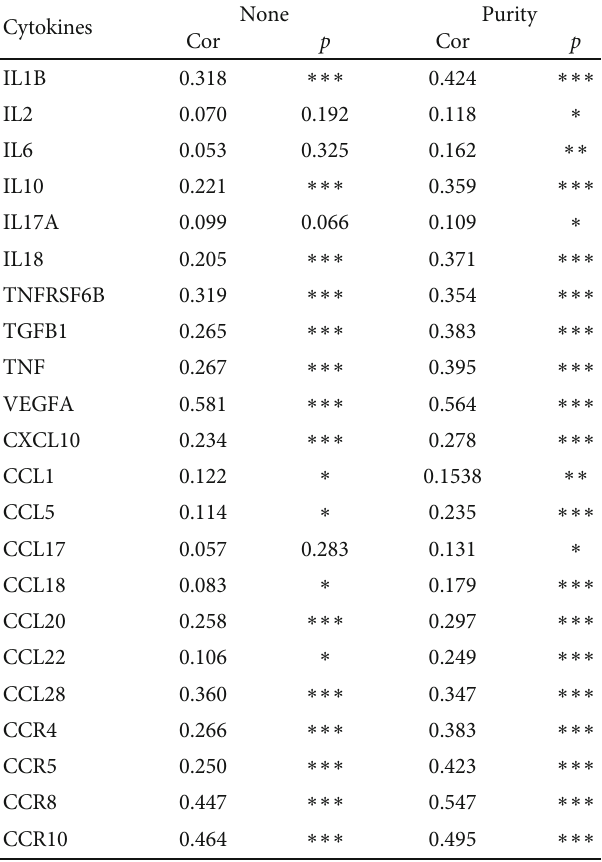
Table 2: Correlation analysis between PRC1 and cytokines in LIHC.